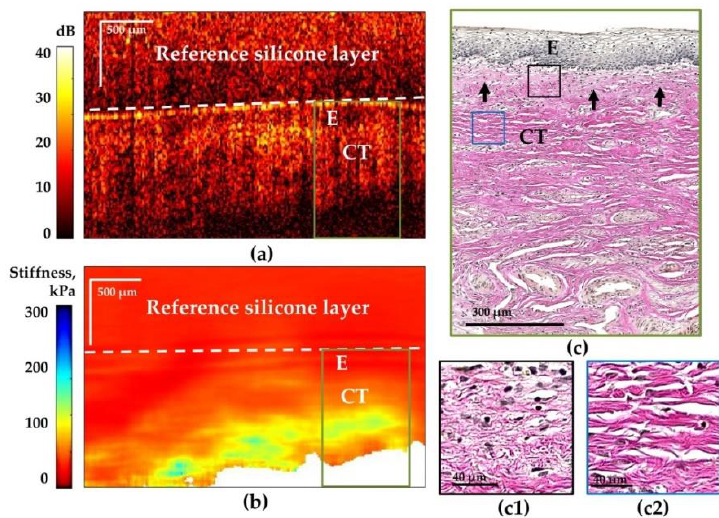
Figure 3. Representative depth-wise structural OCT ( a ) and C-OCE ( b ) images of stages I–II vaginal wall prolapse without preoperative treatment with the corresponding histology ( c – c2 ). The right column ( c , c1 , c2 ) is the histological slide stained with Van Gieson’s, where ( c )—the overview image shows the subepithelial layer of loosely arranged collagen bundles (arrows) and a deeper layer with enlarged spaces between them, which indicates a decrease in the uniformity of their location ( × 100); black square ( c1 )—the area of the submucosal connective tissue with thin, loosely arranged collagen bundles ( × 1000); and blue square ( c2 )—deep area of the submucosal connective tissue with linear organized collagen bundles ( × 1000). The white dotted lines on OCT ( a ) and C-OCE ( b ) images are the transition boundary between the calibration silicone layer and the tissue under study. The green rectangle on OCT ( a ) and C-OCE ( b ) images is the area corresponding to the histological image on ( c ). Abbreviations: E − epithelium, СТ − connective tissue.